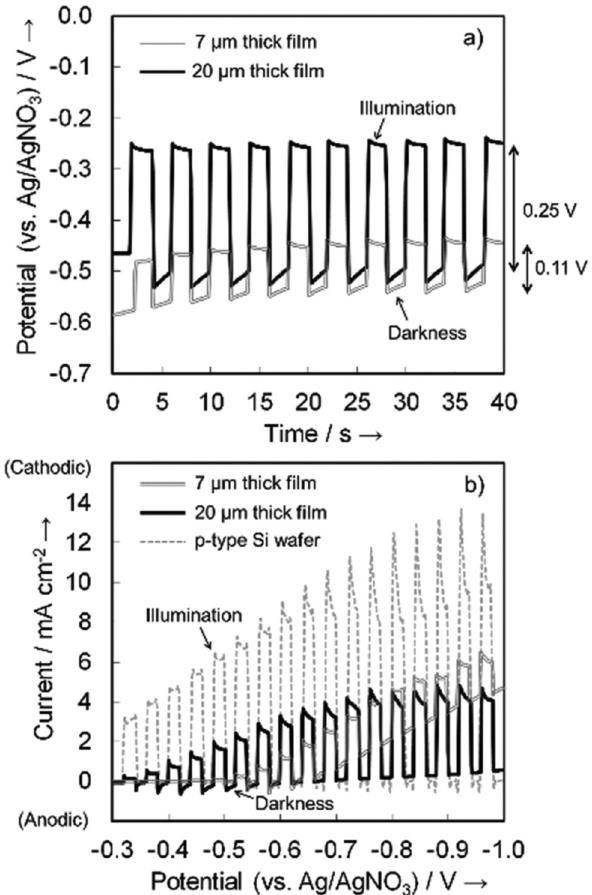
Figure 7: ( a ) Variation in open - circuit potentials and ( b ) photocur - rent - potential characteristics for the deposited Si fi lms and p - type Si wafer in darkness and under illumination at 100 mW · cm − 2 [ 125 ] . Light interval was 2 s. Permission from Wiley.